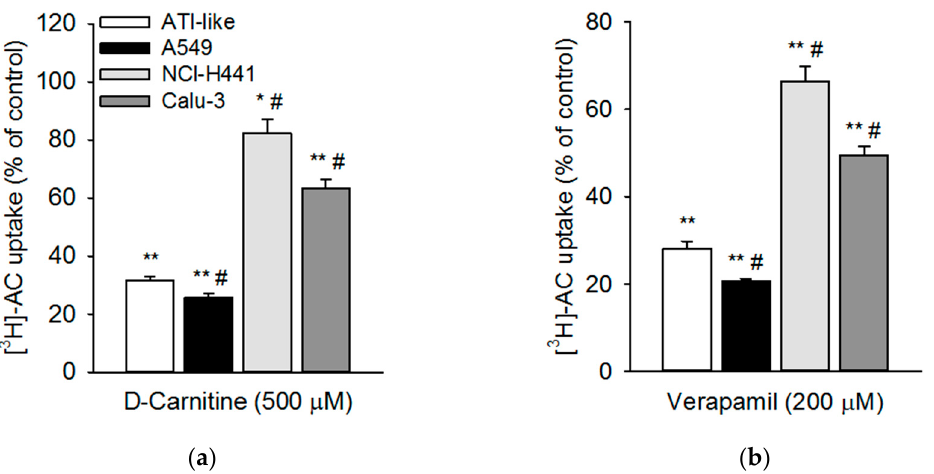
Figure 3. Effect of OCTN2-modifying pharmacophores on the uptake of [ 3 H]-AC into human respiratory epithelial cell monolayers. Uptake of [ 3 H]-AC into ATI-like (white columns), A549 (black columns), NCl-H441 (light grey columns), and Calu-3 (dark grey columns) epithelial cells was measured after 20 min at 37 °C and at pH 7.4 in the presence of ( a ) D -carnitine (500 µM) and ( b ) verapamil (200 µM). The results were obtained by calculating the difference between uptake at 37 °C and 4 °C. Data represent mean ± SEM ( n = 3–6). ** p < 0.01; * p < 0.05 indicates a significant difference from the uptake at pH 7.4 (control). # p < 0.05 indicates a significant difference from data obtained in ATI-like monolayers.